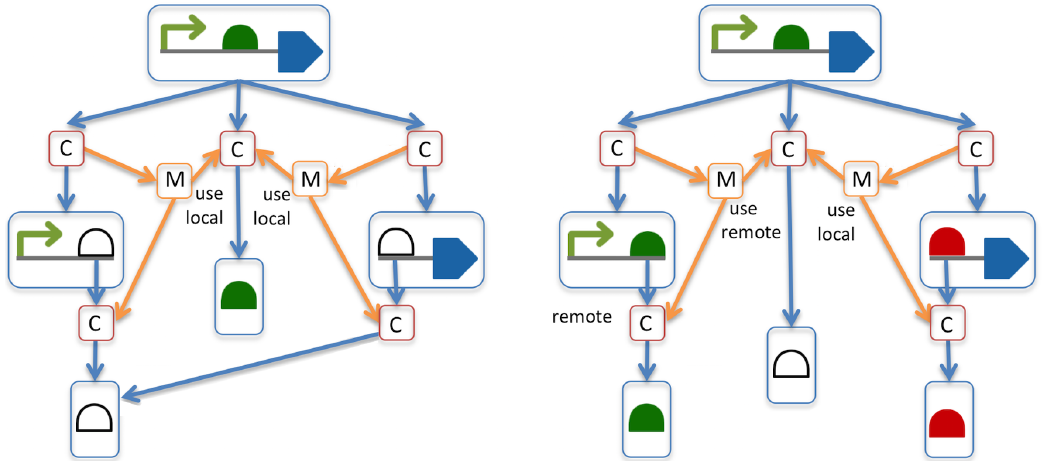
Figure 10: Linking Component objects using MapsTo entities. Boxes with diagrams represent ComponentDefinition objects, boxes with the C label represent Component objects, and boxes with the M label represent MapsTo objects.